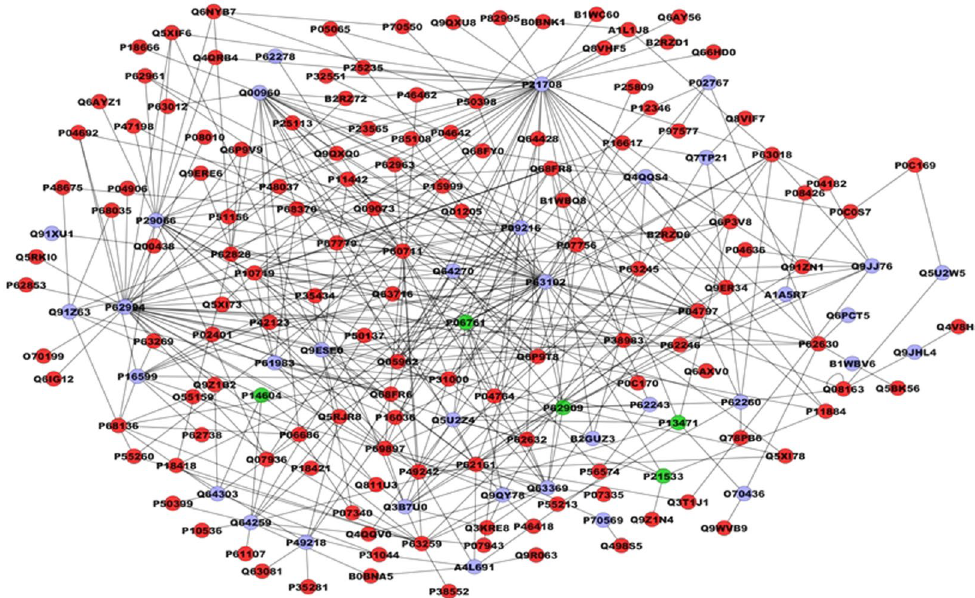
Figure 4. Subnetworks generated by VizMapper for each comparison − 50 ppm F vs. Control Group. Color of node indicates the differential expression of the respective protein, for each comparison. Red nodes indicate protein down-regulation. Gray node indicates proteins presenting interaction but that were not identified in the present study. The access numbers in grey nodes correspond to: Putative RNA exonuclease NEF-sp (A1A5R7), PIN2/TERF1-interacting telomerase inhibitor 1 (A4L691), Aplp1 protein (B1WBV6), Mthfd1l protein (B2GUZ3), Mothers against decapentaplegic homolog 2 (O70436), Transthyretin (P02767), Protein kinase C epsilon type (P09216), Tumor necrosis fator-TNF (P16599), Mitogen-activated protein kinase 3-Mapk3 (P21708), Beta-arrestin-1 (P29066), Melatonin receptor type 1A (P49218), 14-3-3 protein gamma (P63102), 40S ribosomal protein S8 (P62243), 14-3-3 protein epsilon (P62260), 40S ribosomal protein S13 (P62278), Growth factor receptor-bound protein 2 (P62994), 14-3-3 protein zeta/delta (P63102), Unconventional myosin-Vb (P70569), Glutamate receptor ionotropic, NMDA 2B (Q00960), Ripk2 protein (Q3B7U0), Tubulin beta-3 chain (Q4QQS4), Transducin beta-like protein 3 (Q5U2W5), Nuclear factor of kappa light polypeptide gene enhancer in B-cells 2, p49/p100 (Q5U2Z4), Nuclear factor NF-kappa-B p105 subunit (Q63369), Von Hippel- Lindau disease tumor supressor (Q64259), Translation initiation factor eIF-2B subunit alpha (Q64270), Serine/ threonine-protein kinase PAK 2 (Q64303), Polyglutamine-binding protein 1 (Q6PCT5), Cb1-727 (Q7TP21), Protein quaking (Q91XU1), E3 ubiquitin-protein ligase TRIM63 (Q91Z63), Epidermal growth factor receptor related protein (Q91Z63), Epidermal growth factor receptor related protein (Q9ESE0), Drebrin-like protein (Q9JHL4), Casein kinase 1 epsilon (Q9JJ76), and Inhibitor of nuclear factor kappa-B kinase subunit beta (Q9QY78). The access numbers in green nodes correspond to: 78 kDa glucose-regulated protein (P06761), 40S ribosomal protein S14 (P13471), Enoyl-CoA hydratase, mitochondrial (P14604), 60S ribosomal protein L6 (P21533), and 40S ribosomal protein S3 (P62909). The names of the proteins corresponding to each access number in the red nodes are listed in the Supplementary Table